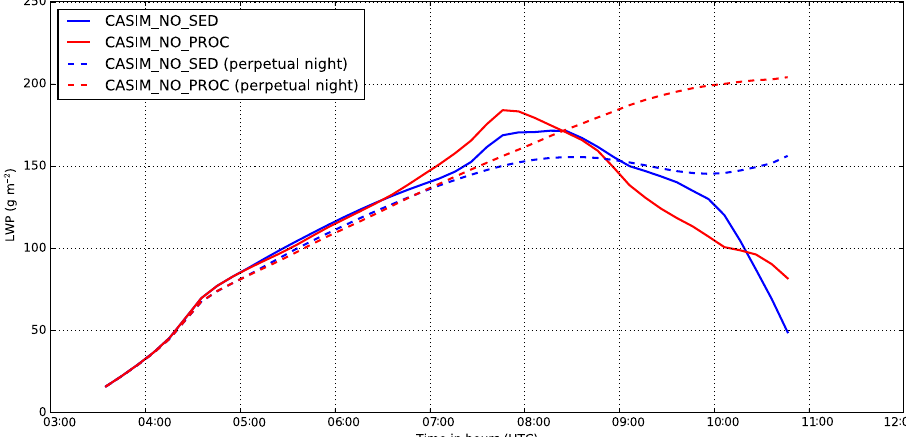
Figure 10. Time series of simulated LWP (gm − 2 ) from CASIM_NO_PROC (solid red line) and CASIM_NO_SED (solid blue line). Dashed lines show results from “perpetual night” simulations, i.e. with shortwave radiation disabled and surface fluxes set to zero throughout the simulation period. In each case, LWP is calculated from 200m to the top of the model domain in order to ignore the thin fog layer near the surface that develops during the spin-up period and dissipates around